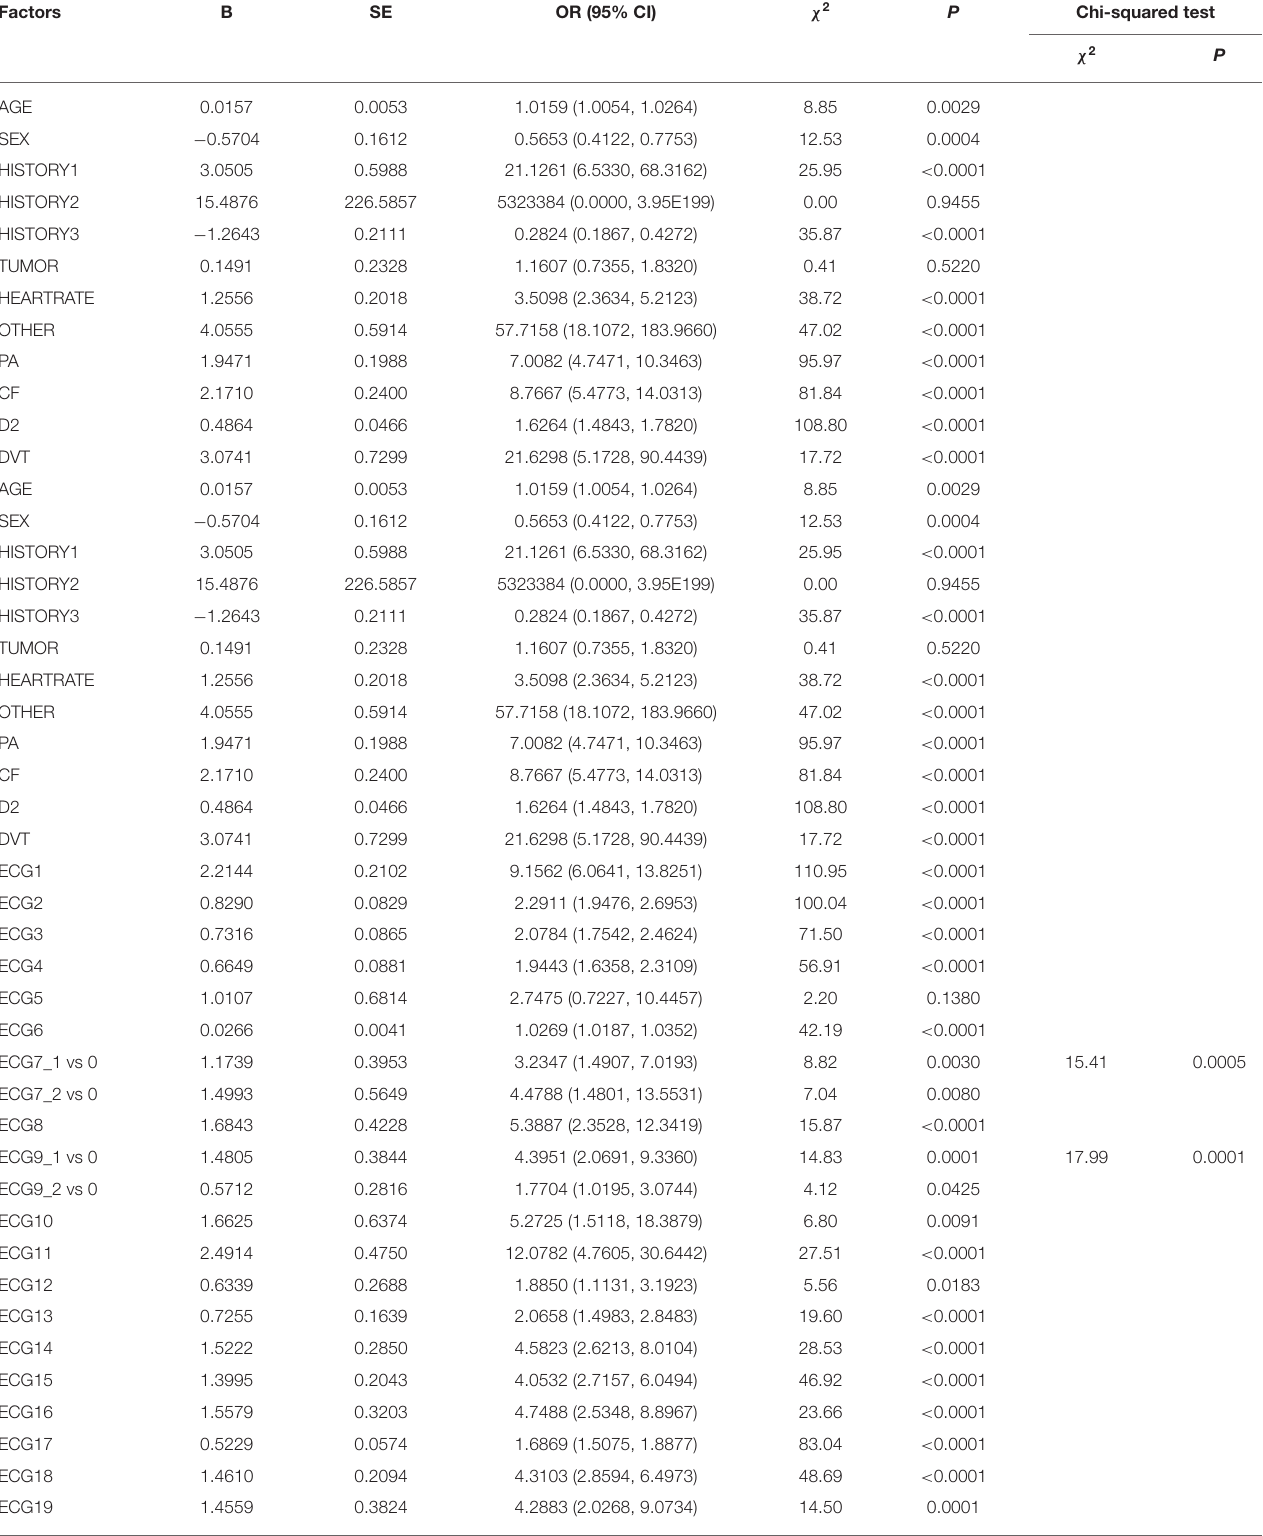
TABLE 3 | The result of univariate logistic regression analysis.